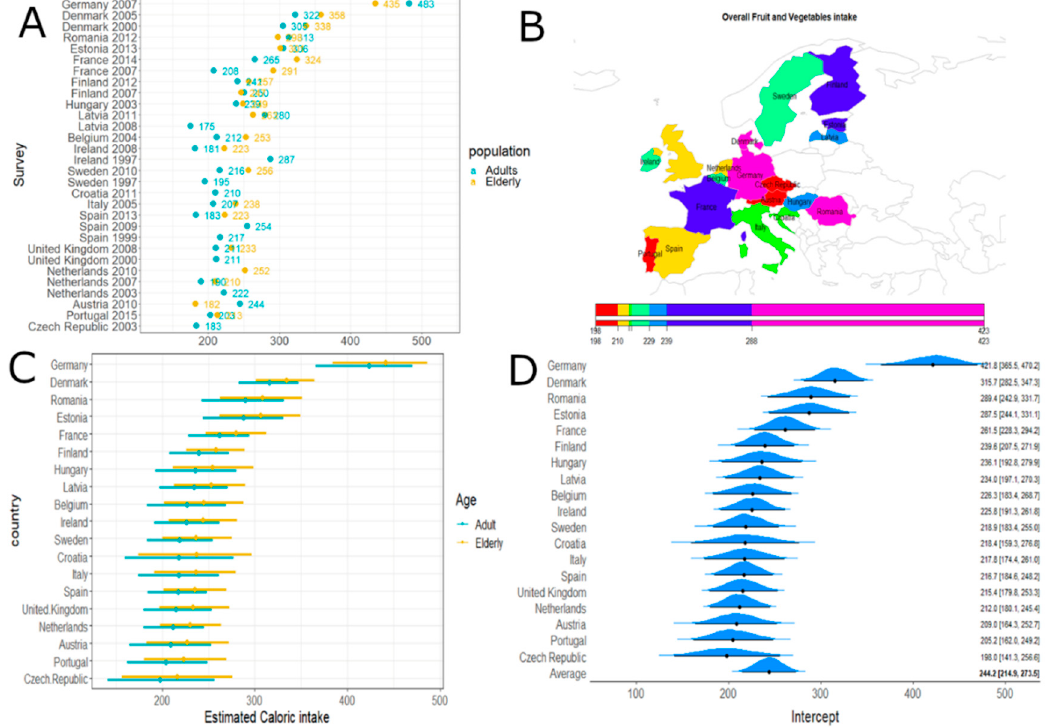
Figure 2. Overall fruit and vegetable caloric intake. Panel ( A ): Overall fruit and vegetable caloric intake (obtained by summing the means over the L7 levels) according to surveys and age classes. Panel ( B ): Estimated caloric intake across European countries. Panel ( C ): Estimated caloric intake across European countries according to age classes with 95% credibility intervals. Average effect estimate (95% CI) 244.18 [214.94; 273.52] and age effect (95% CI) 18.09 [–0.41; 37.43]. Panel ( D ): Estimated caloric intake across European countries (without age effect) with 95% credibility intervals. Concerning vegetable products, the greatest consumption was observed in Romania, Italy, and France. Sweden, Austria, and Germany showed the lowest intake (Figure 3). No differences were demonstrated across age classes.